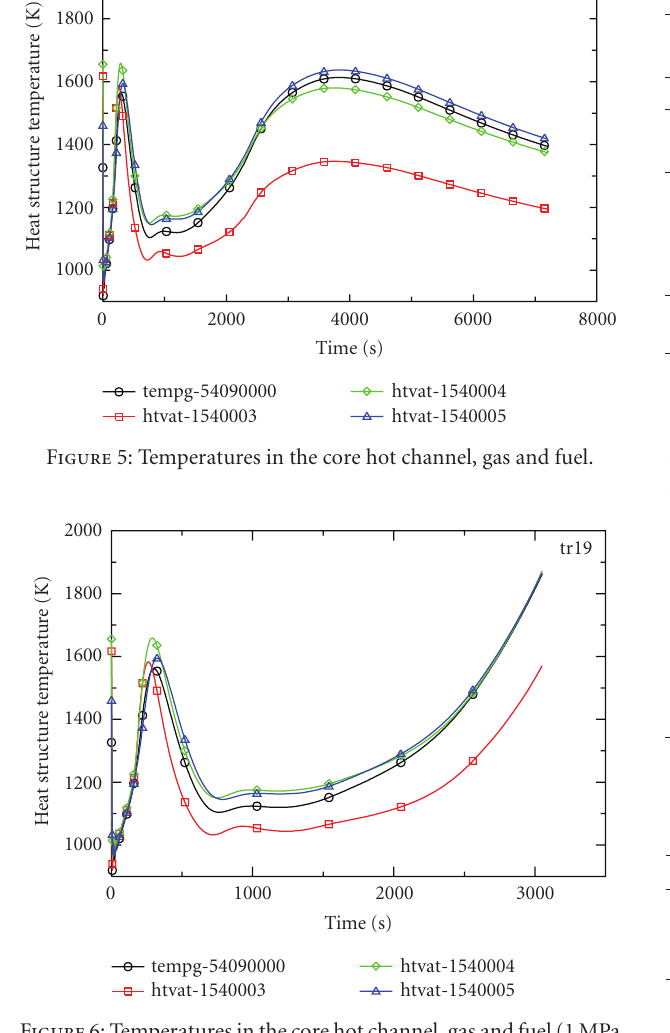
Figure 6: Temperatures in the core hot channel, gas and fuel (1MPa case).